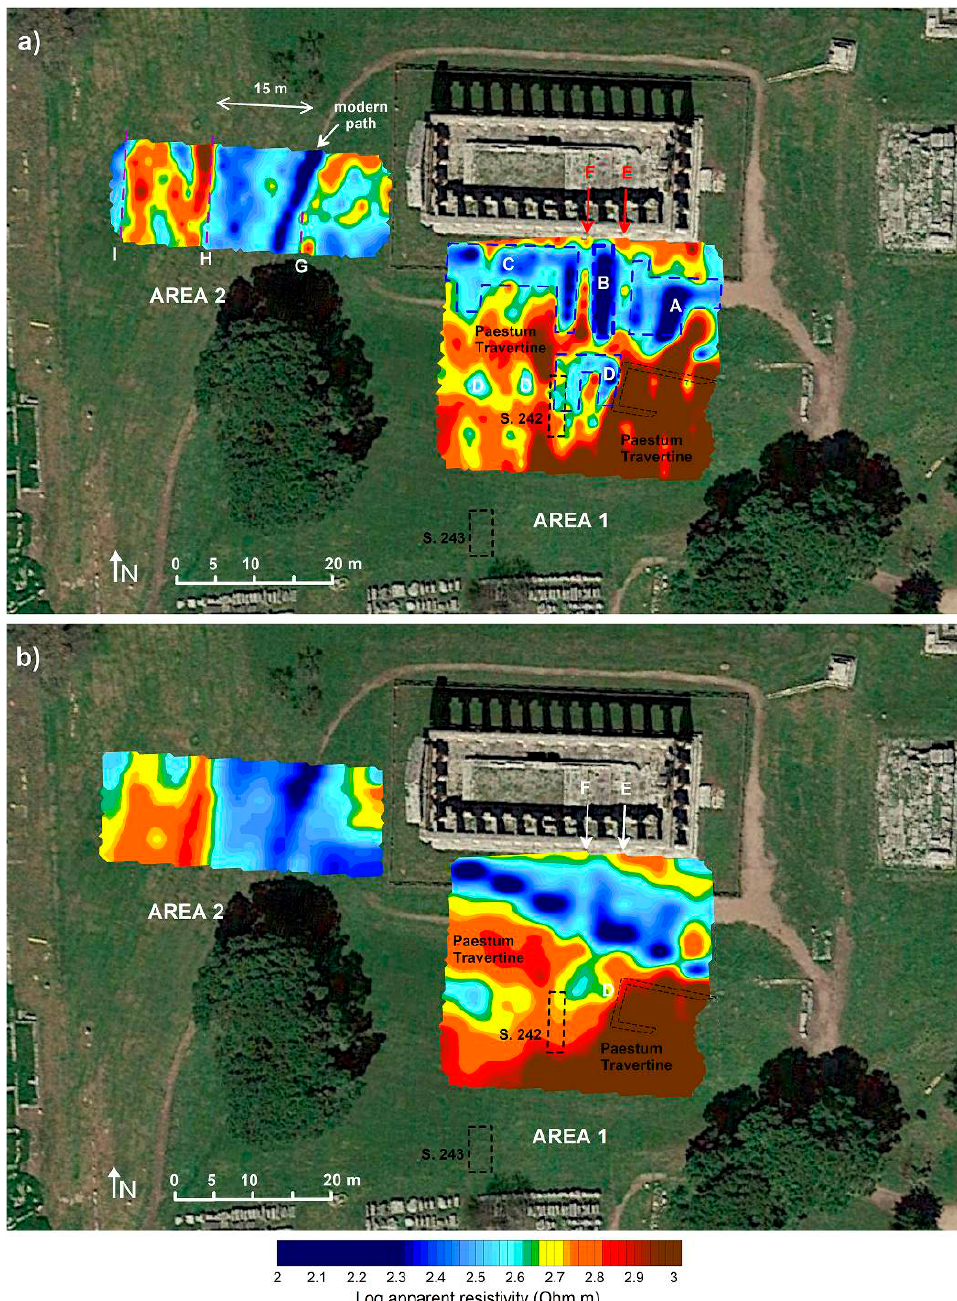
Figure 14. Horizontal tomography sections relative to the depths of 1 m ( a ) and 2 m ( b ), superimposed on a Google Earth TM satellite image. on a Google Earth TM satellite